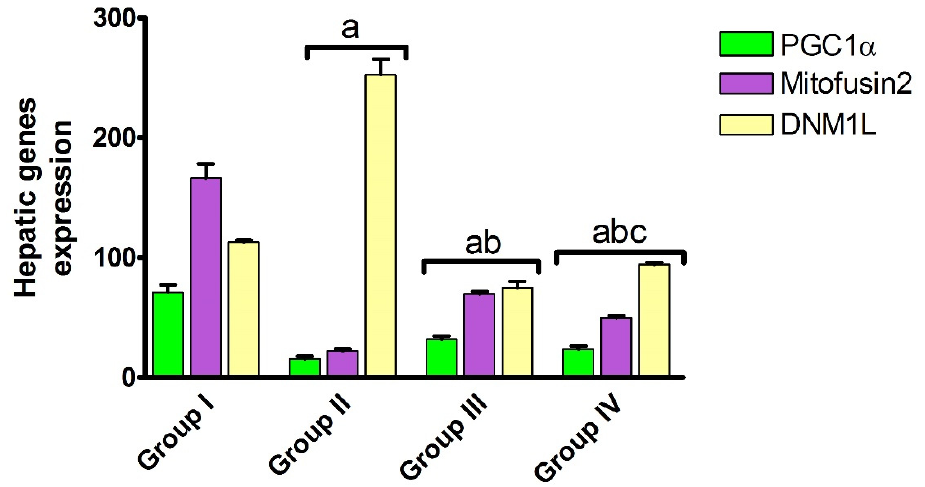
Figure 3. Effect of carvedilol on hepatic PGC-1 α , mitofusin 2, and DNM1L expression in hepatic ischemia associated with isoprenaline-induced AHF. Group I: naïve, Group II: control positive, Group III: pre-treated carvedilol, Group IV: post-treated carvedilol. Data presented as mean ± SEM. a p < 0.05 versus group I, b p < 0.05 versus group II, c p < 0.05 versus group